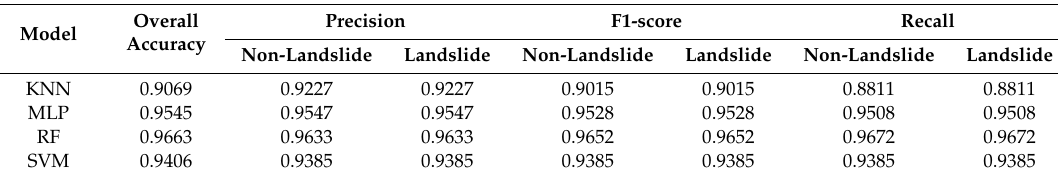
Table 3. Performance evaluation indicators of the machine learning based landslide susceptibility models.